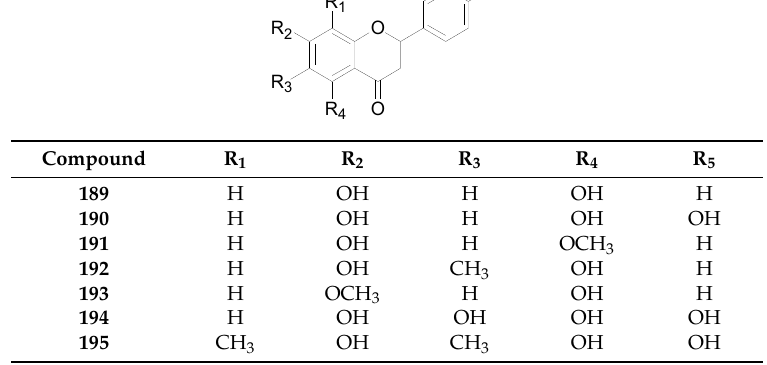
Table 13. Structures of compounds 189 – 195 .